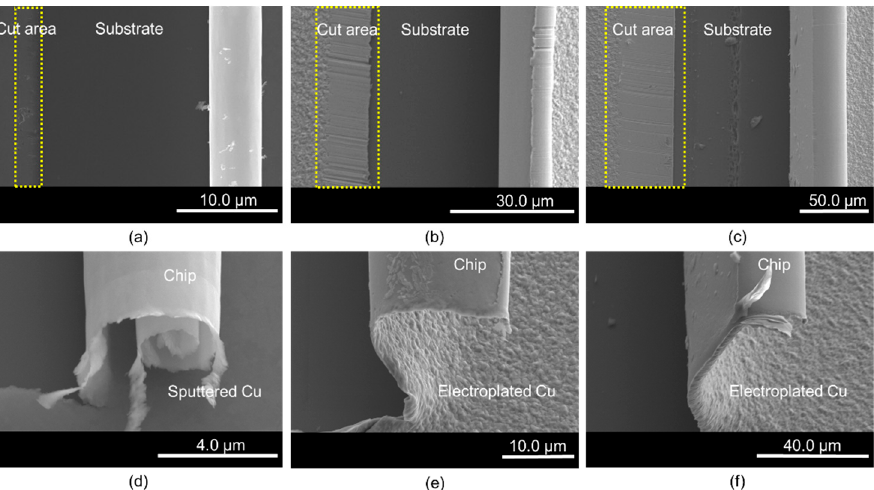
Figure 4. Morphology of cut Cu films: ( a ) top view of the sputtering Cu (130 nm); ( b ) top view of the electroplated Cu (1.5 μ m); ( c ) top view of the electroplated Cu (5 μ m); ( d ) cutting chip of the sputtered Cu film (130 nm); ( e ) cutting chip of the electroplated Cu film (1.5 μ m); ( f ) cutting chip of the electroplated Cu film (5 μ m).